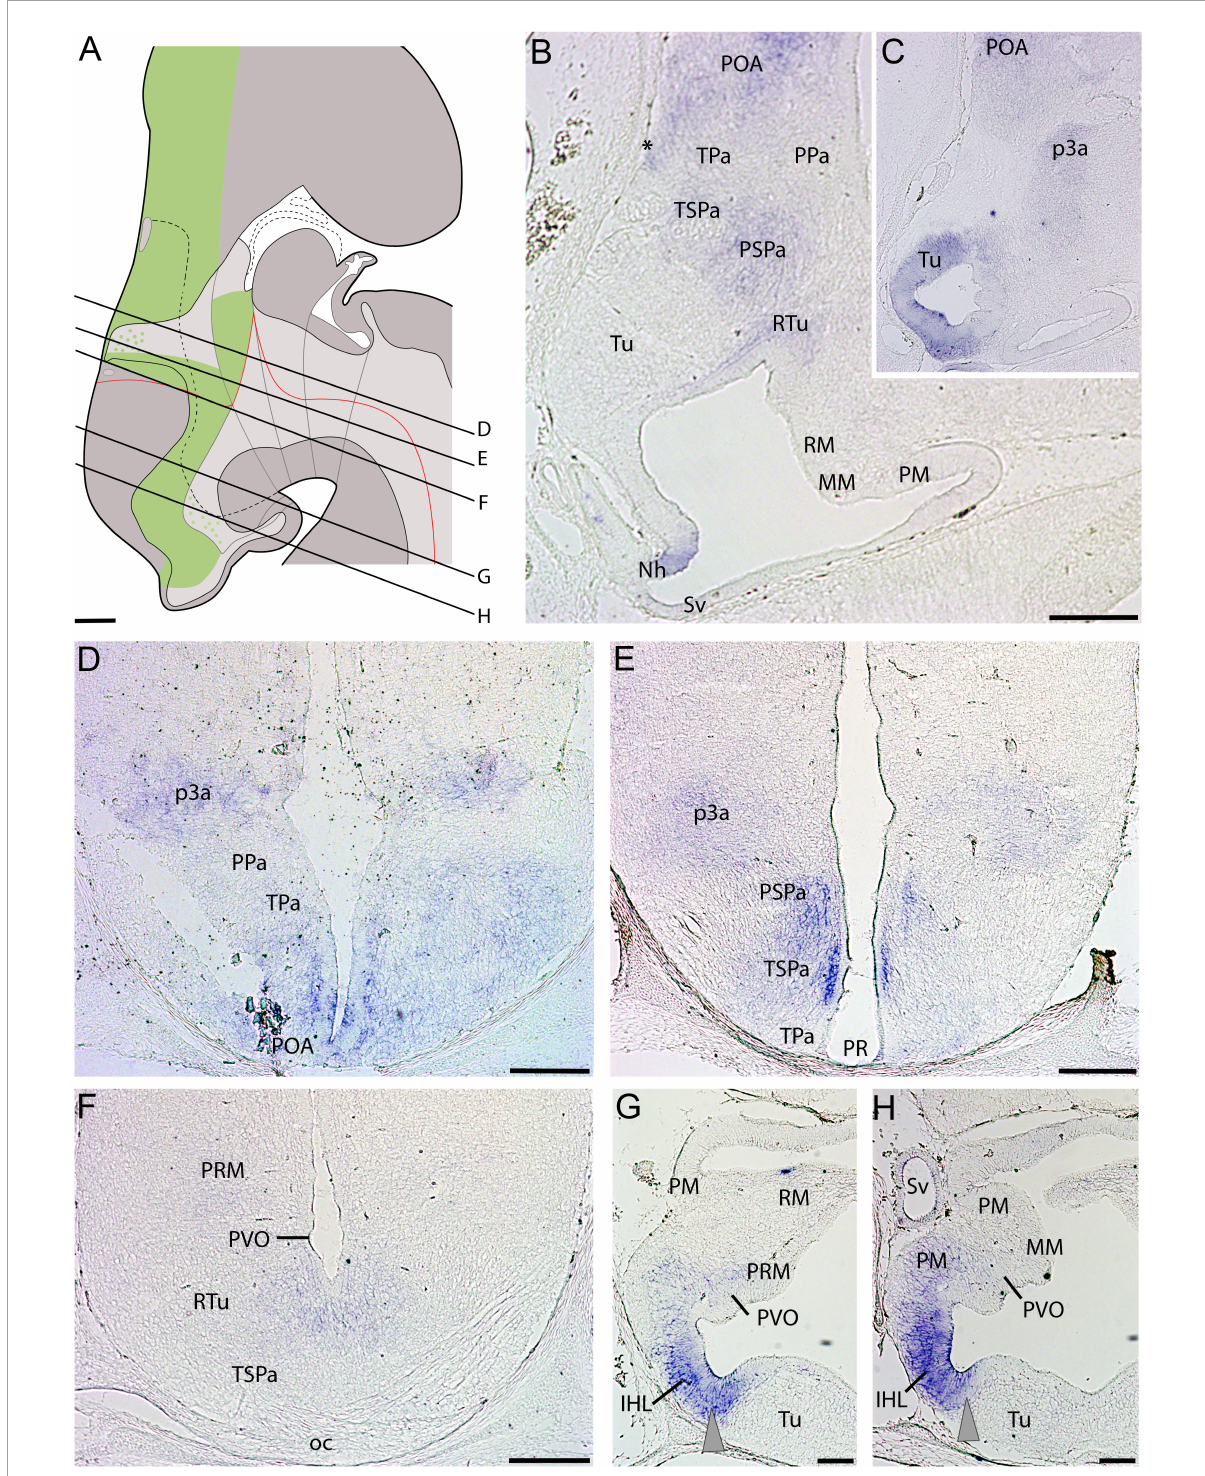
FIGURE3 Regionalization of the hypothalamus of Scyliorhinus canicula at stage 32 based on the expression of ScDlx2 (green color in A ) by means of in situ hybridization ( B–H ) in sagittal ( B,C ) or transverse ( D–H ) sections. Scheme on (A) represent a maximal projection of the expression found in sagittal and parasagittal sections. Lines represent the level of transverse sections. Ventricular labeling is represented with solid color while mantle cells are represented with dots. Gray arrowheads in (G,H) point to ScDlx2 expression in the inferior hypothalamic lobes. For abbreviations, see list. Scale bars: 125 µ